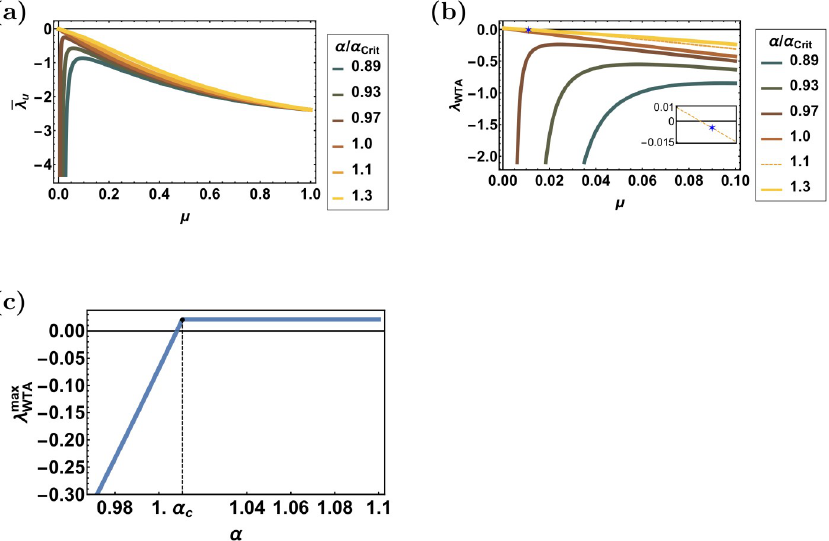
Fig 4. The uniform and winner-take-all eigenvalues. ( a ) The uniform eigenvalue, � l different values of α / α c , depicted by color. ( b ) The competitive eigenvalue of the winner-take-all mode, λ WTA , is shown as a function of μ , for different values of α / α c , depicted by color. (Inset) Enlarged section of the figure, showing the eigenvalue corresponding to the choice of parameters of Fig 8a–8d, depicted by a blue asterisk. ( c ) The maximal value of λ WTA in the interval μ 2 [0, 1] is shown as a function of α . Note that for α � α c , l max = 0. The eigenvalues were computed for the asymmetric STDP rule, Eq (11). Unless stated otherwise, the following parameters were used: σ = 0.6, D = 10Hz, N = 120, τ − = 50ms, τ + = 20ms and d = 10ms.